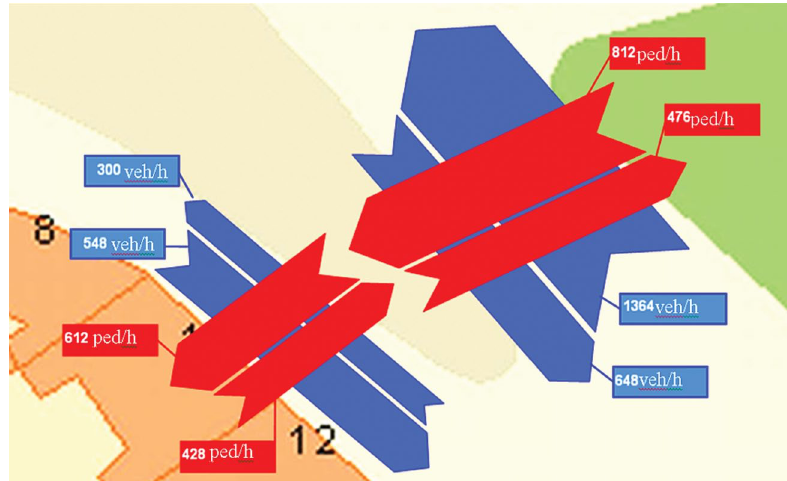
Fig. 3. The intensity of pedestrian and motorized traffic (Vujanić et al.